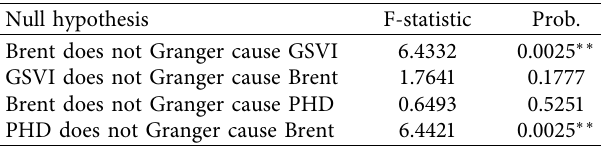
Figure 8: Schematic diagram of the time window concept. Table 9: Result of Granger causality